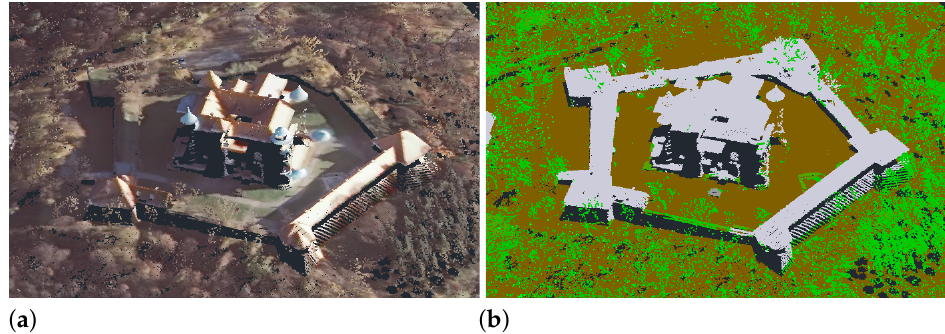
Figure 10. ISOK point cloud: scanning colours ( a ); class colours ( b ).